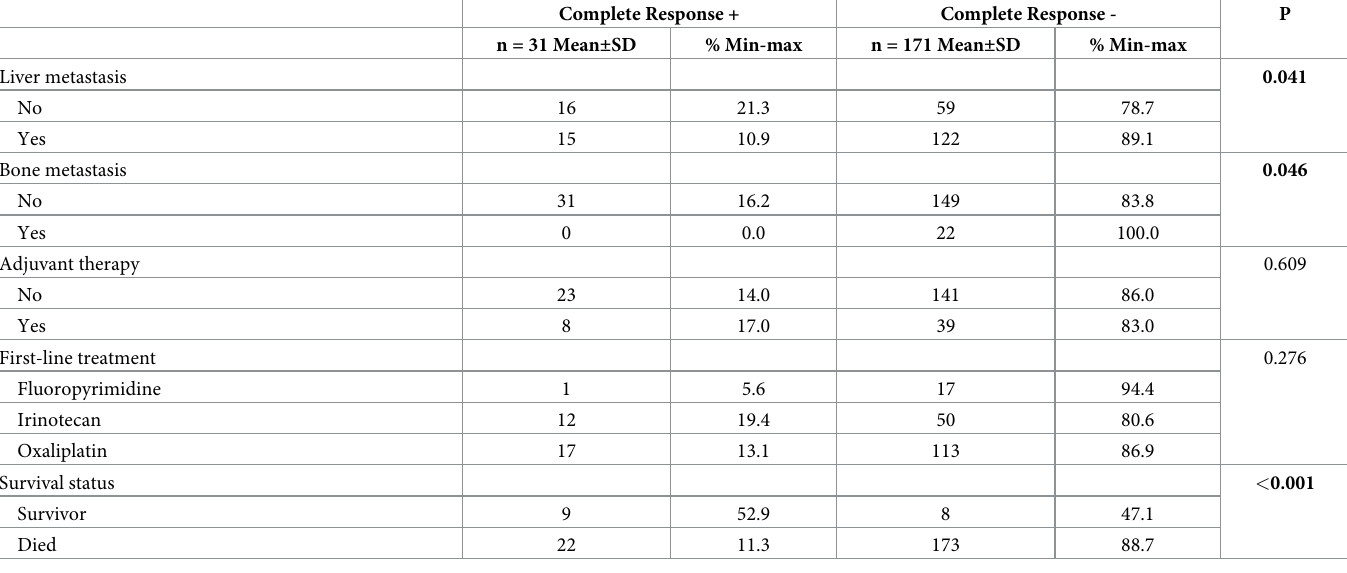
line treatment with fluoropyrimidine and a first-line treatment combination with irinotecan significantly increased OS ( p = 0.007 , p = 0.003 , respectively). First-line treatment with combi- nation treatment compared with single-agent fluoropyrimidine was found to increase OS sta- tistically significantly ( p = 0.002 , HR: 2.196, 95% CI: 1.339–3.600). It was found that attaining